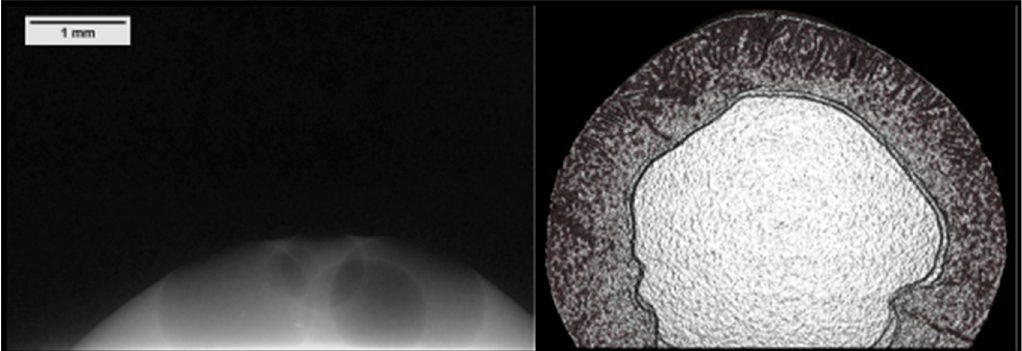
Figure 7. L: Coagulation of chicken protein (radiographic image); R: Slice of a partly dried chicken Figure 7. Left : Coagulation of chicken protein (radiographic image); Right : Slice of a partly dried protein particle. chicken protein